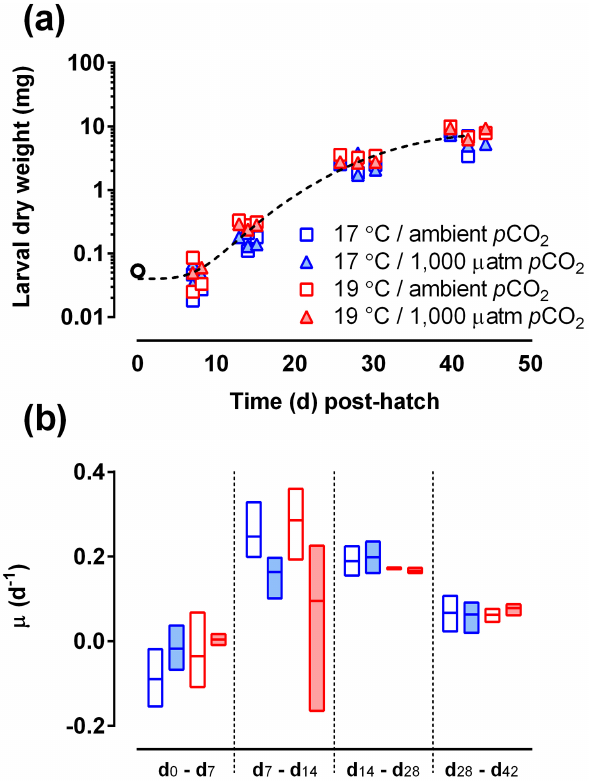
Fig. 3. (a) Dry weight of sea bass larvae incubated for 42 days under each experimental condition. Data points are mean values for each experimental tank; open circle= d 0 data, line=nonlinear regression (Weibull model using shared parameters across treat- ments). (b) Specific growth rate µ of D. labrax larvae after incu- bation for 42 days under each experimental condition calculated for each tank between each sampling point. Bottom and top of floating bars are minimum and maximum values, horizontal lines are means. See Table 1 for details on each experimental